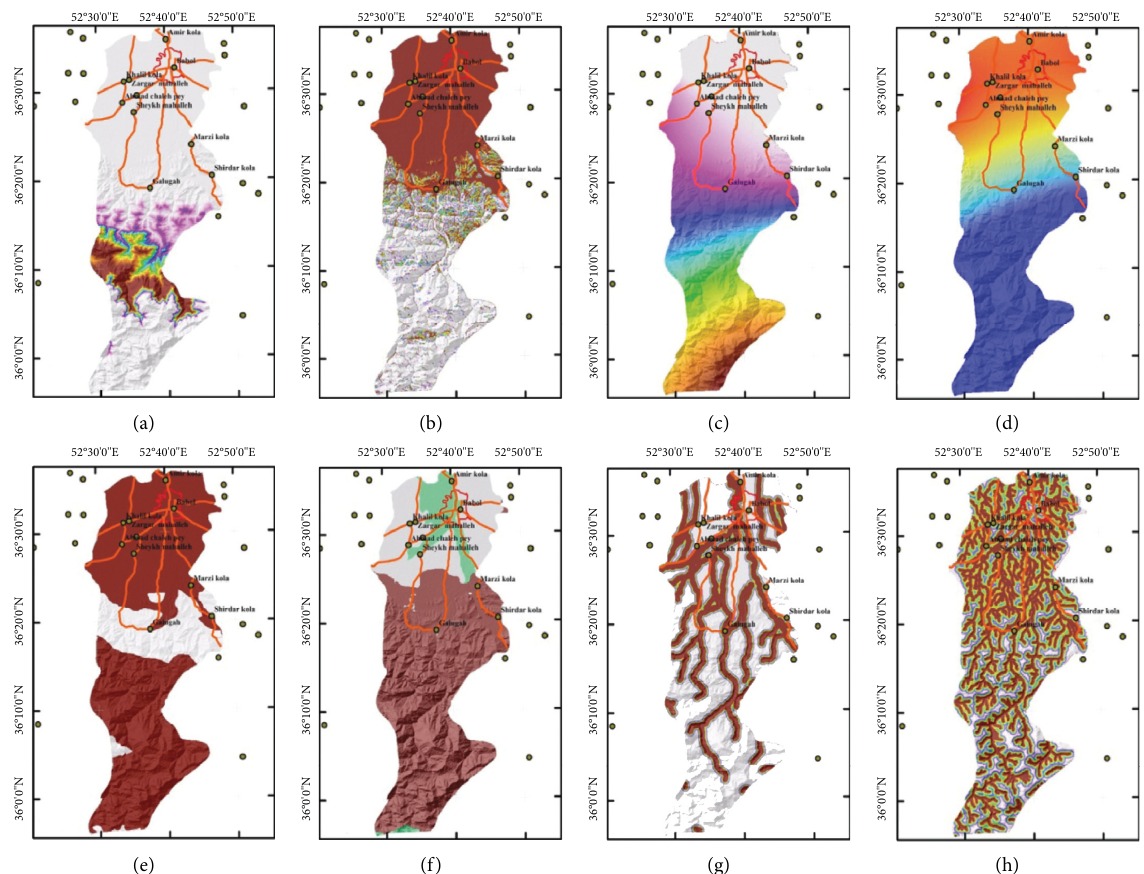
Figure 3: Areas of performance appraisal: (a) elevation, (b) slope, (c) precipitation, (d) temperature, (e) geology units, (f) landform, (g) distance to river, and (h) distance to stream.